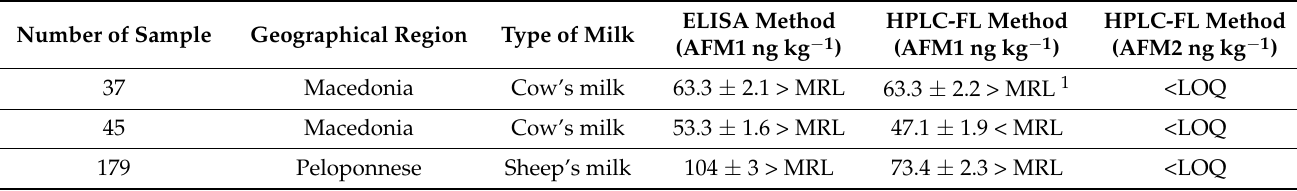
Table 4. The results from the analysis of the positive milk samples as determined by ELISA and the HPLC-FL method. Number of Sample Geographical